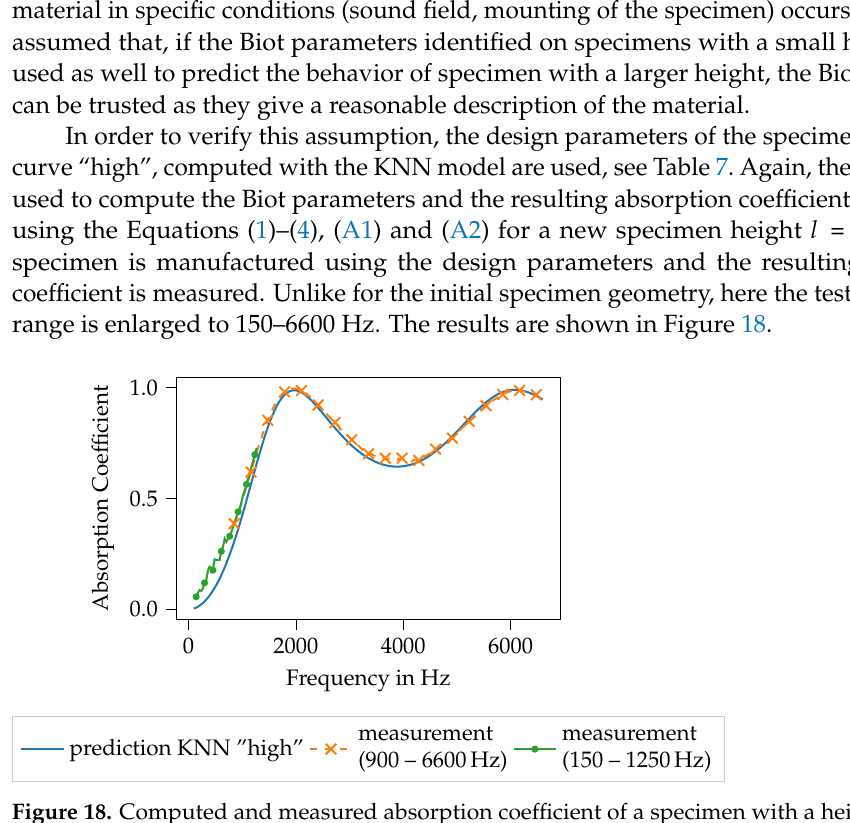
Figure 18. Computed and measured absorption coefficient of a specimen with a height l = 30mm and enlarged frequency range 150–6600 Hz. The computation employs the Biot parameters obtained from the KNN model for traget curve “high” and computes the absorption coefficient using the Equations (1)–(4), (A1) and (A2) for the new specimen